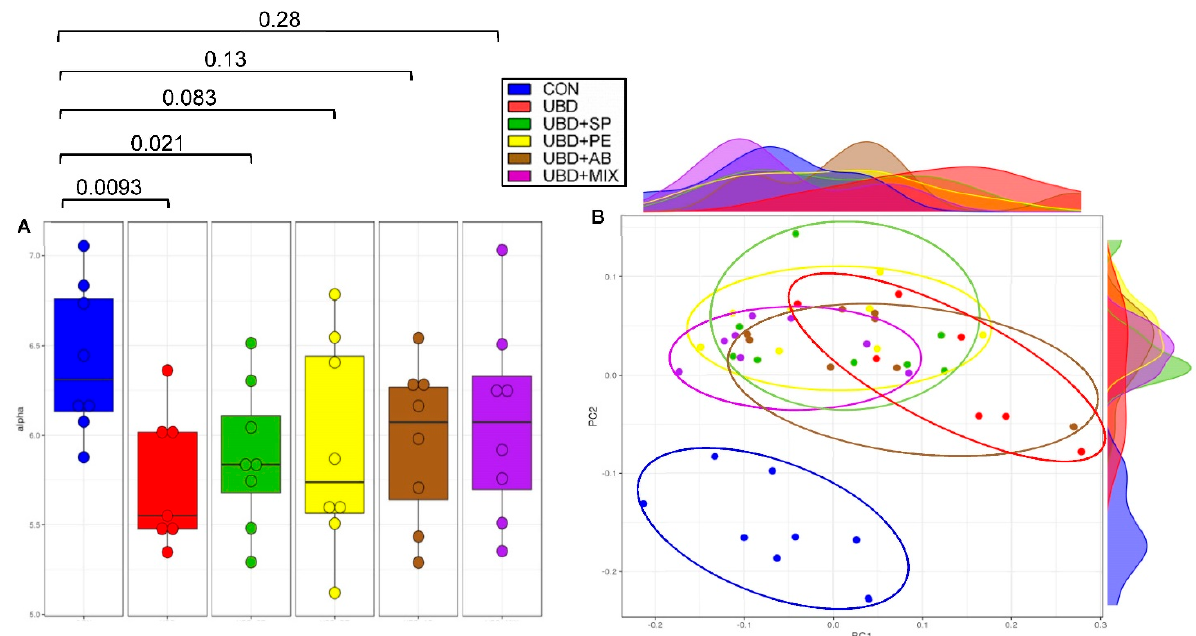
Figure 7. Bacterial diversity between and within samples. ( A ) Alpha diversity was calculated using Shannon index. ( B ) Principal coordinates analysis was calculated based on bray-curtis distances matrix. p -value was calculated using Pairwise comparisons Wilcox. Test.